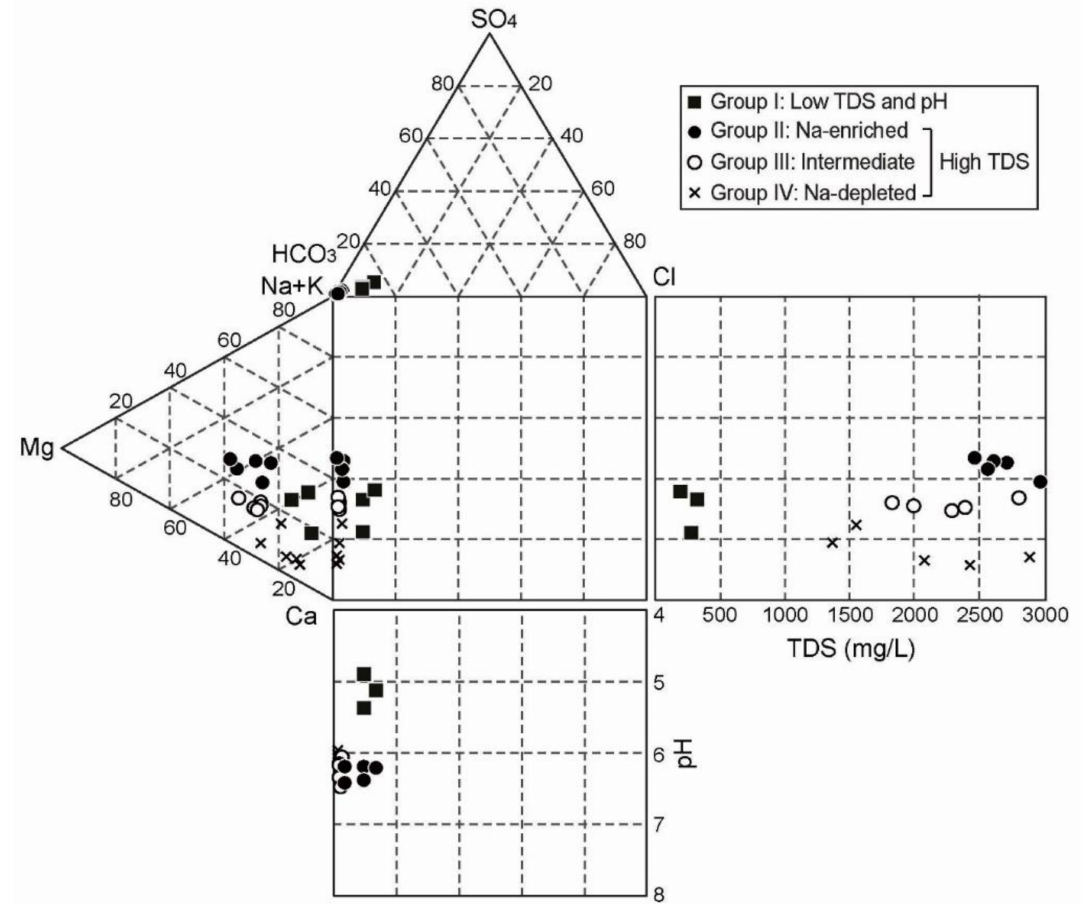
Figure 2. Durov diagram showing the hydrochemical compositions of water samples (n = 18) from the CO 2 -rich springs (n = 8). They are clustered into four groups by pH, total dissolved solids (TDS), and Na contents, while all show the Ca-HCO 3